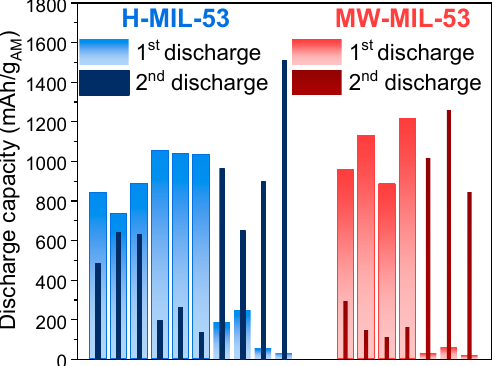
Figure 5. Discharge capacities at the first (light color bars) and second (dark color bars) discharges